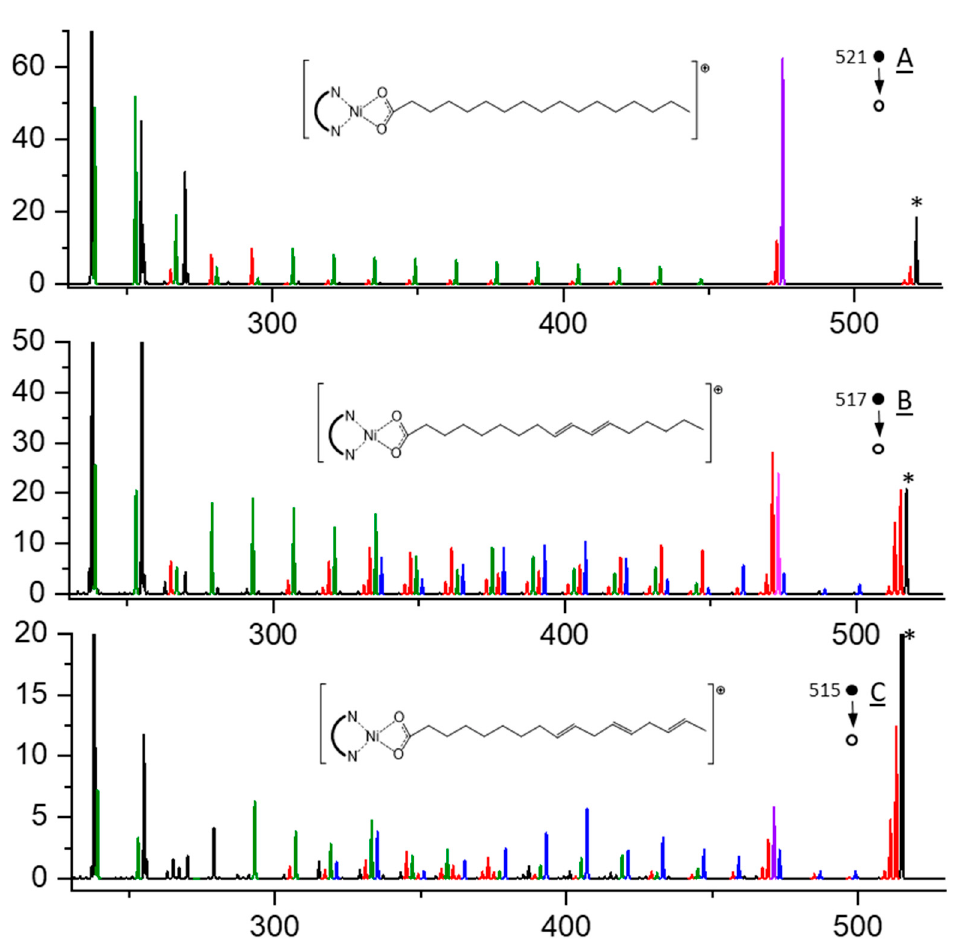
Figure 2. CID of [(phen)Ni(OOCR)] + for R = C 16 H 33 ( A ), C 16 H 29 ( B ), and C 16 H 27 ( C ) (A = stearate, B = linoleate, C = linolenate). Red peaks correspond to dehydrogenation of the parent peak immediately to the right. Blue peaks are the result of cracking of the hydrocarbon chain without deoxygenation (number of neutral carbons lost in neutral molecule). Purple represents deoxygenation, while green indicates cracking of the hydrocarbon chain after deoxygenation. * indicates the mass-selected precursor ion.